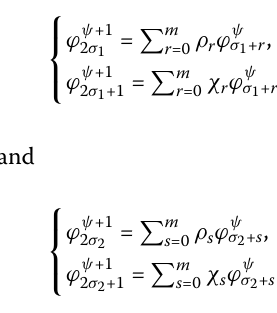
Illustration of the old points and the new points by GTPBRS is shown in Fig. 1. In this figure, red lines and red bullets represent mesh and points at the ψ th refinement step, respectively, while black lines and black bullets represent the refined mesh and refined points by GTPBRS at the ( ψ + 1)th refinement step,